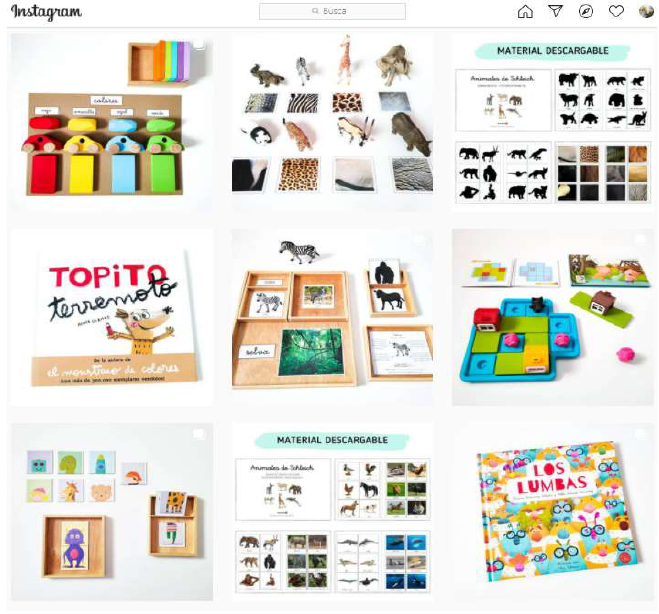
Figure 6. Example of an esthetic feed. Source: @entrenubesespeciales.